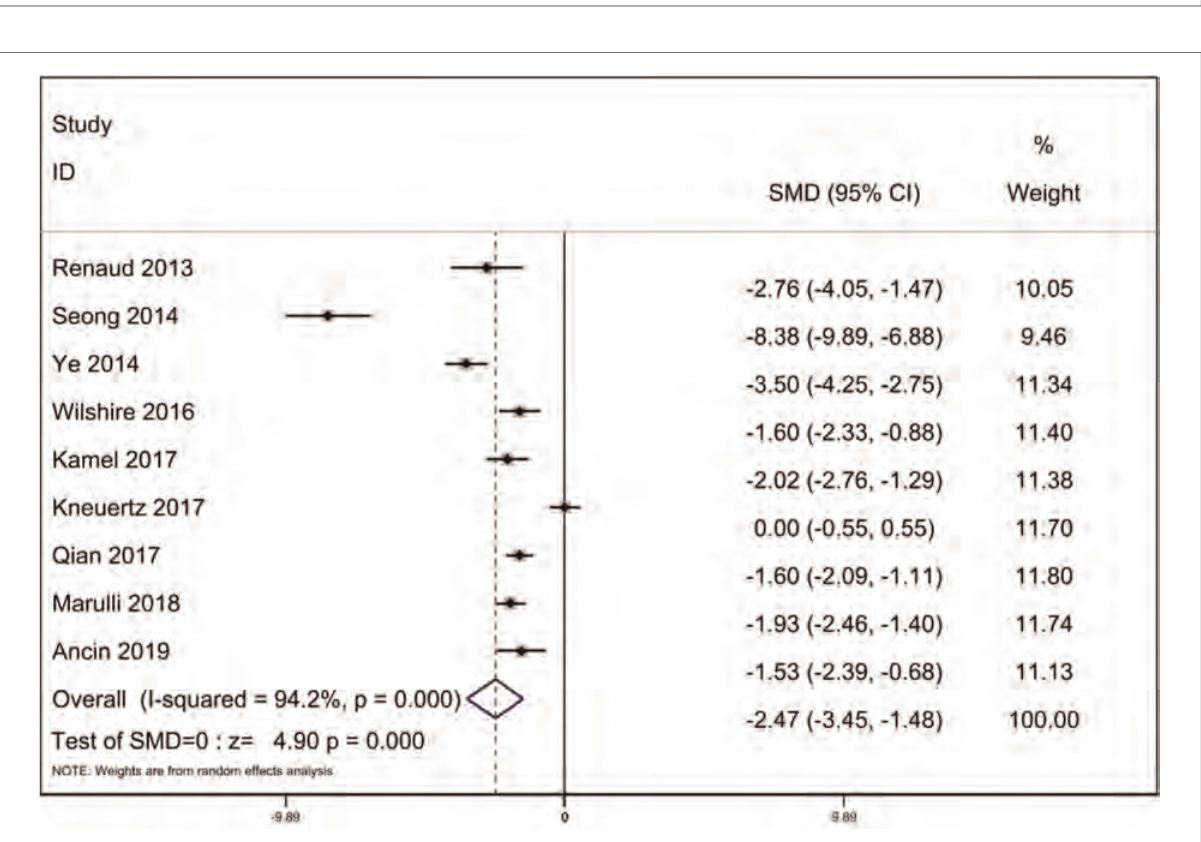
FIGURE 4 Comparison of operation blood loss between RATS and ST. SMD, standardized mean difference; CI, con fi dence interval; RATS, robot-assisted thoracoscopic surgery; ST, sternotomy.